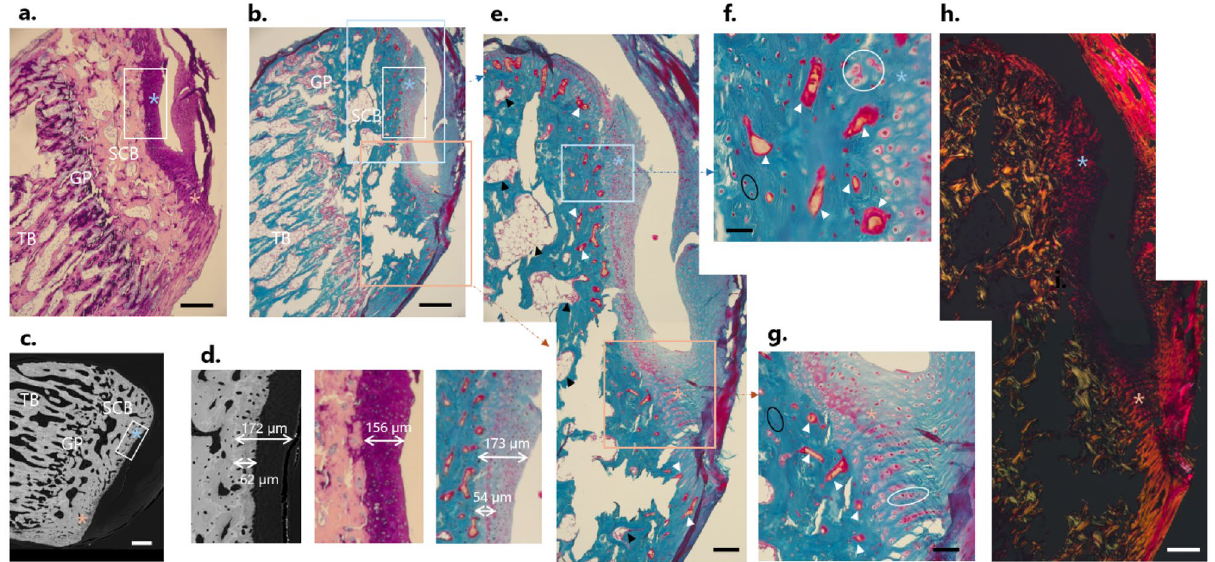
Figure 4. Histological and backscattered electron imaging (BEI) analysis from two sagittal sections stained with Giemsa and Goldner. Bright field light microscopy images of a thin section stained with Giemsa ( a ) and Goldner trichrome ( b ) at a similar location, as well as BEI ( c ), highlighting the areas of interest: trabecular bone (TB), growth plate (GP), subchondral bone (SCB), as well as periosteal fibrocartilage (light blue asterisk) and enthesis fibrocartilage (light pink asterisk). Scale bars: 250 µm. ( d ) Zoom from white frames in ( a – c ) on the periosteal fibrocartilage with BEI, Giemsa and Goldner, respectively, suggesting a thickness of the mineralized layer of about 50 µm corresponding to the reddish band in Goldner image. ( e ) Magnifications of light blue and pink frames from ( b ) illustrating some subchondral trabecular pores (black arrows) and subchondral vascular channels (white arrows). Scale bar: 100 µm. ( f ) Magnified view from frame in ( e ), revealing chondrocytes arrangement in fibrocartilage (white circle), as well as osteocytes in bone (black circle) and subchondral vascular channels (white arrows). Scale bar: 25 µm. ( g ) Magnified view at the insertion, from frame in ( e ), showing the column-like organization of chondrocytes, in close vicinity with osteocytes (black circle) and subchondral vascular channels (white arrow). Scale bar: 50 µm. ( h ) Polarized light microscopy corresponding to images in (e) suggesting a high degree of alignment of collagen fibers at the insertion. Scale bar: 100